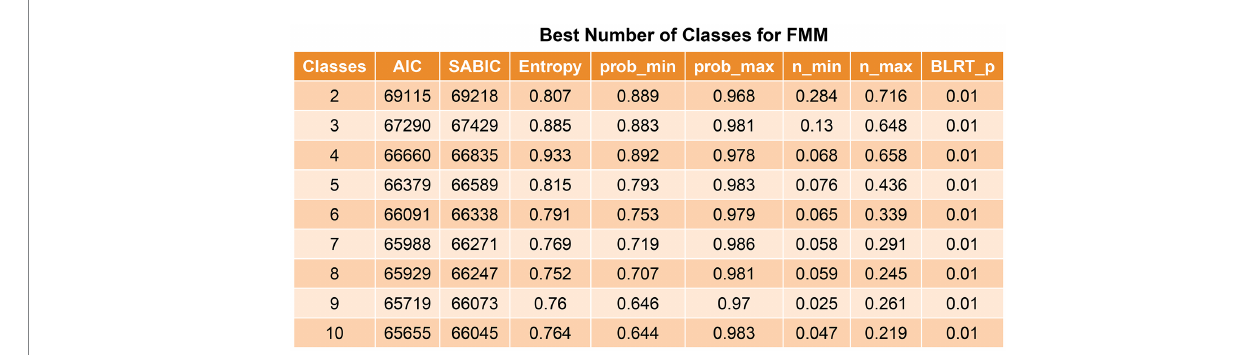
FIGURE 2 Best number of classes for latent profile analysis. The value of p was reported for the bootstrap likelihood ratio test comparing the current model (k class) to the model with k-1 class. AIC, Akaike information criterion; SABIC, sample size-adjusted Bayesian information